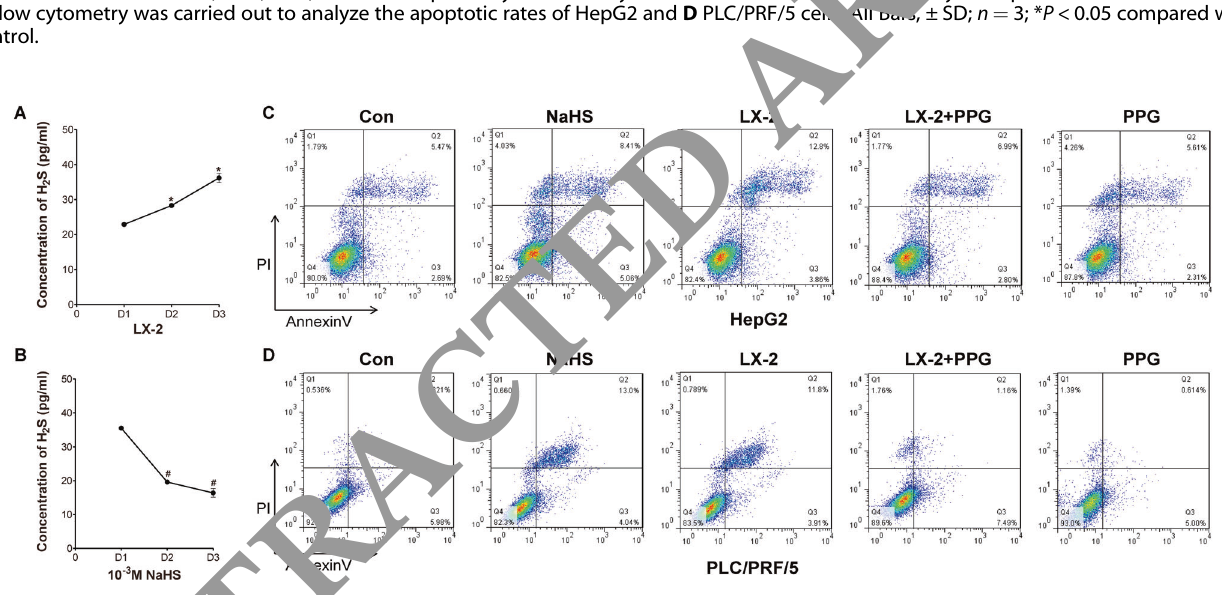
Fig. 2 LX-2 cells induce apoptosis of HCC cells through releasing H 2 S. The amount of H 2 S released by cultured LX-2 cells ( A ) and 10 – 3 M NaHS ( B ) were measured by ELISA. C, D Flow cytometry was used to analyze the effects of exogenous H 2 S (NaHS) and endogenous H 2 S (LX-2 cells co-cultured or/and added PPG treated) on HCC cells apoptosis. All Bars, ± SD; n = 3; * P < 0.05 compared with D1 group in LX-2 cells, # P < 0.05 compared with D1 group in HepG2